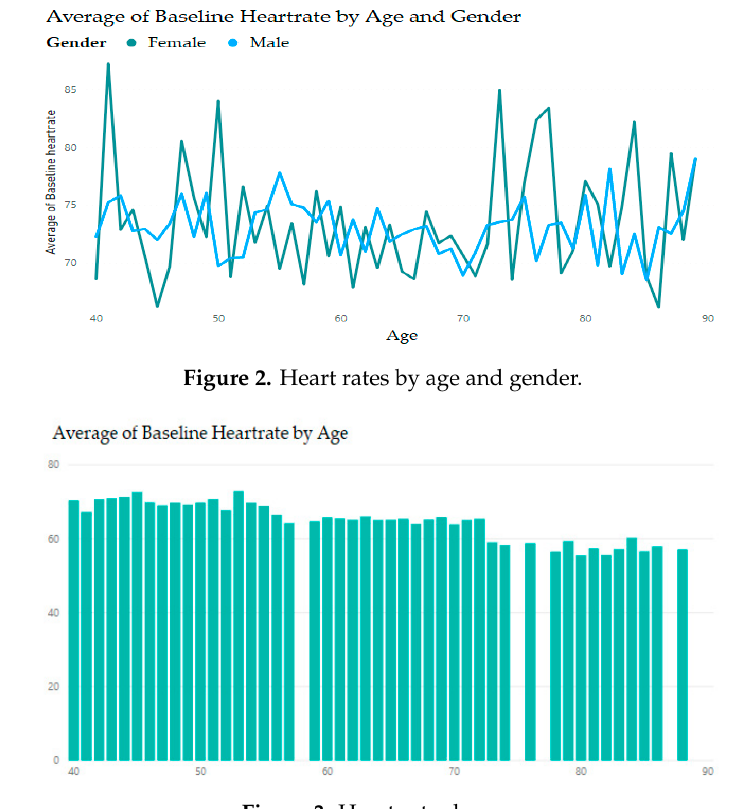
Figure 3. Heart rates by age .